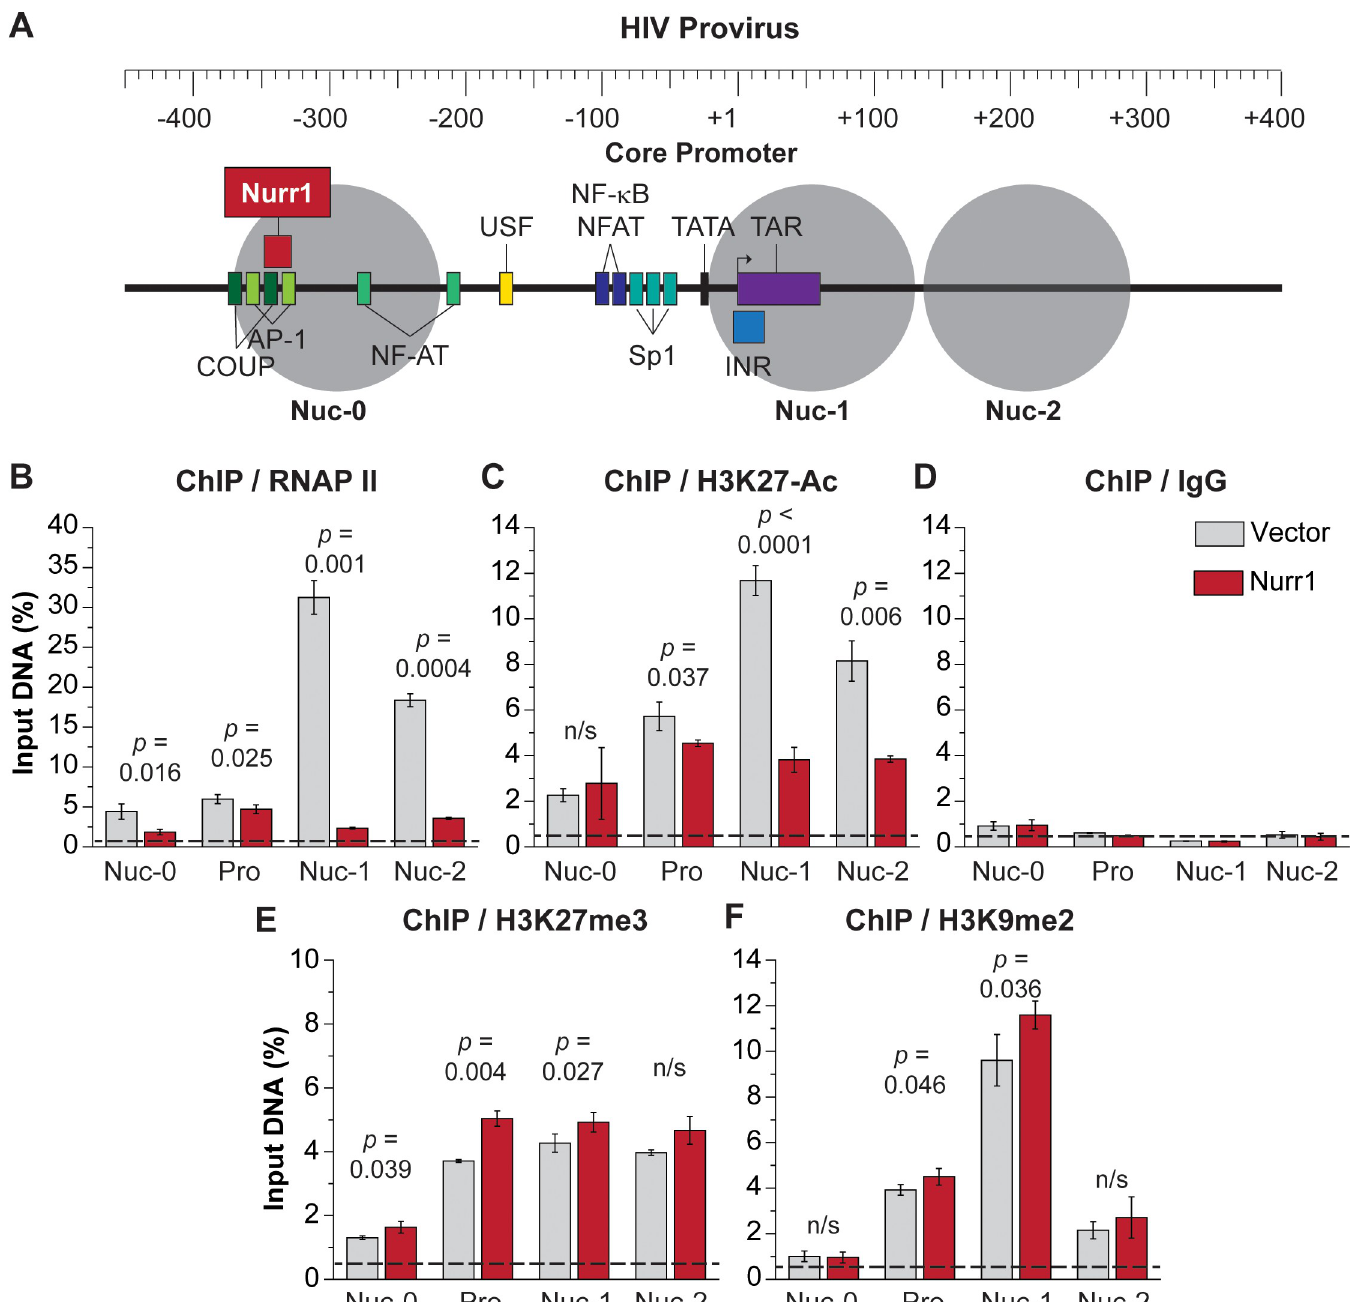
Fig 8. Nurr1 overexpression promotes repressive histone methylation and deacetylation. A , Location of Nurr1 binding site and positions of the Nuc0, promoter, Nuc1, and Nuc2 regions in the HIV-1 LTR. B , ChIP assays with antibodies for RNA polymerase II (RNAP II). C , H3K27-Ac. D , control IgG. E , H3K27me3. F , H3K9me2. HC69 cells infected with either a vector control (grey bars) or a 3X-FLAG-Nurr1 overexpression vector (red bars) were cultured for 48 hr after stimulation with high dose (400 pg/ml) TNF- α for 24 hr. Data is from three technical replicates. Dotted line indicates the IgG background signal. https://doi.org/10.1371/journal.ppat.1010110.g008 ( S3A Fig ). As expected, Nurr1 knockdown increased basal expression approximately 3-fold. In unstimulated control cells, 6-MP treatment reduced the number of GFP+ cells from 30.1% to 15.8% but did not significantly reduce GFP expression in the Nurr1 KD cells. Importantly,